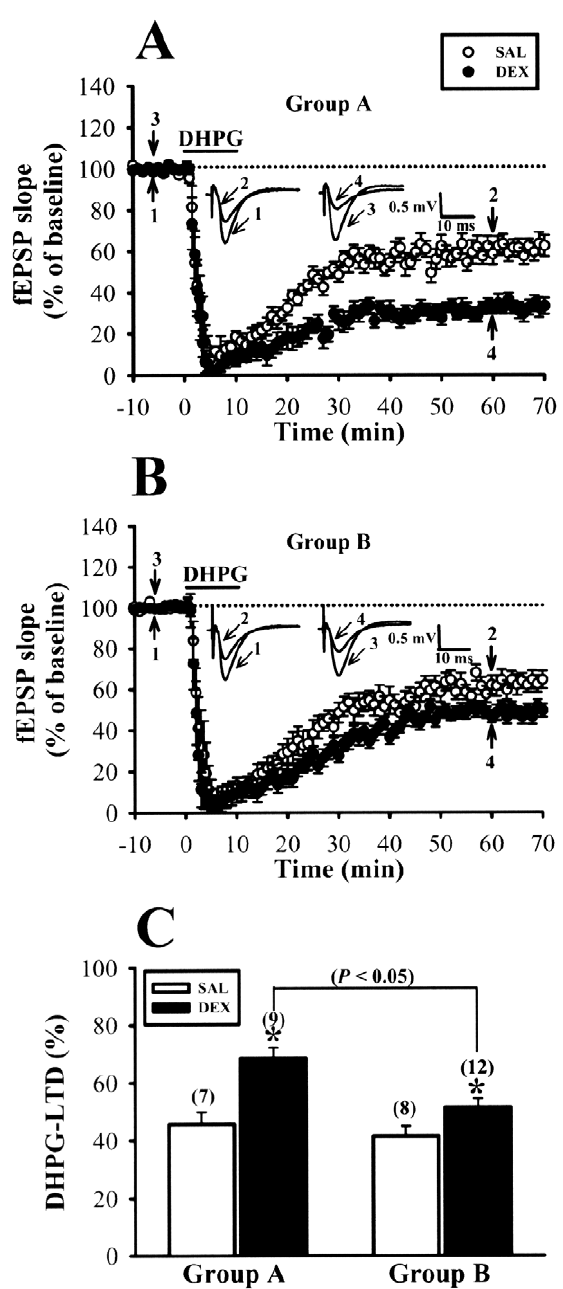
Figure 5. Culling reduces the facilitatory effect of neonatal DEX treatment on DHPG-induced LTD in hippocampal CA1 region. (A) Summary graphs of LTD induced with a brief application of mGluR agonist DHPG (50 m M) for 10 min in slices from 5-week-old rats of Group A that received neonatal SAL or DEX treatment. (B) Summary graphs of LTD induced with a brief application of DHPG (50 m M) for 10 min in slices from 5-week-old rats of Group B that received neonatal SAL or DEX treatment. (C) Summary bar graphs depicting levels of depression measured 50 min after washout of DHPG in slices from neonatal SAL- or DEX-treated rats for Group A and Group B. The total number of animals examined is indicated by n in parenthesis. Representative traces of fEPSPs were taken at the time indicated by number. Horizontal bars denote the period of delivery of DHPG. The dashed lines show the level of baseline. Data represent the mean 6 SEM. *p , 0.05 compared with SAL-treated rats.